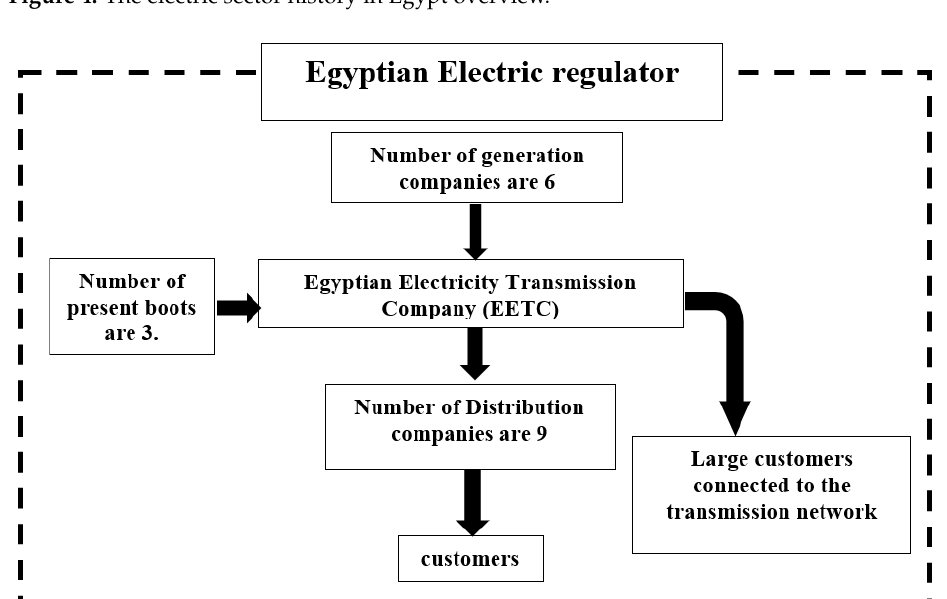
Figure 4. The electric sector history in Egypt overview.